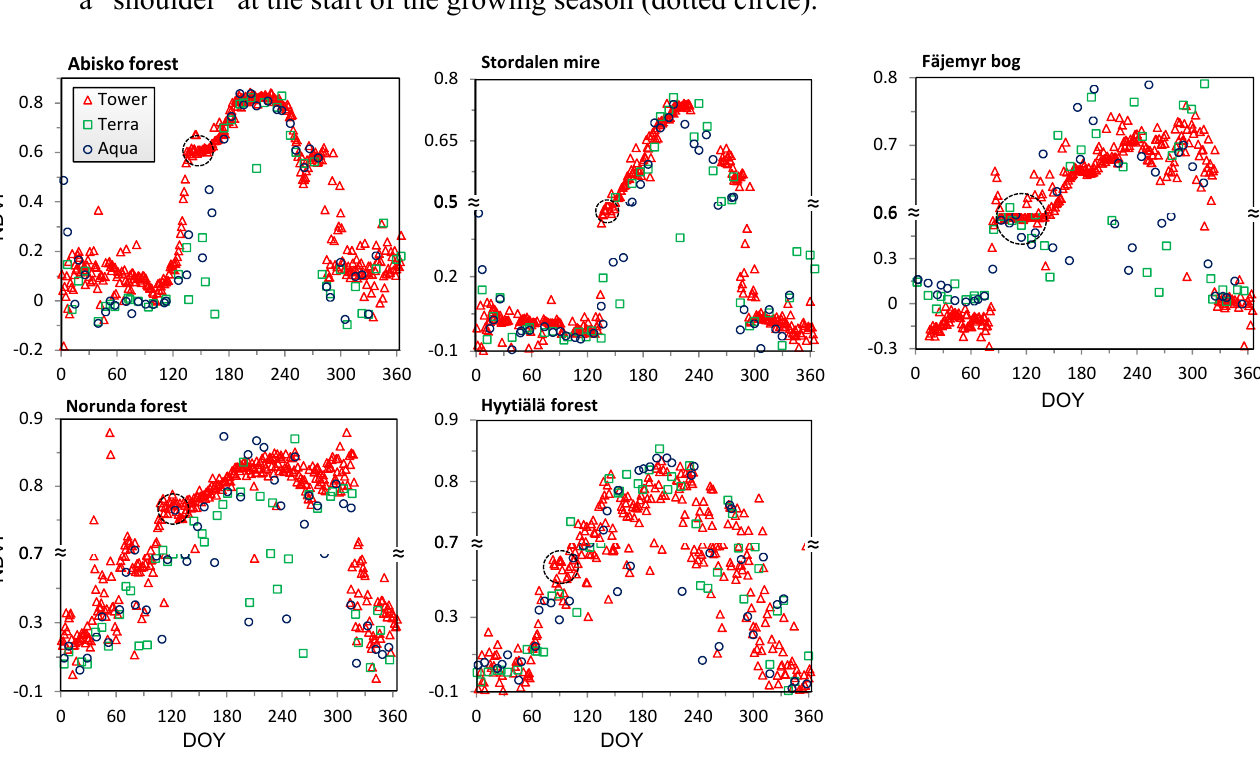
Figure 6. NDVI courses of five sites in 2010. Tower-based NDVI are calculated from measurements at solar noon. Terra and Aqua MODIS-derived NDVI were computed from 8-day composite reflectance. The scales are varied along the y-axes, in order to amplify subtle NDVI variations during the growing seasons. The tower-based NDVI curves expose a “shoulder” at the start of the growing season (dotted